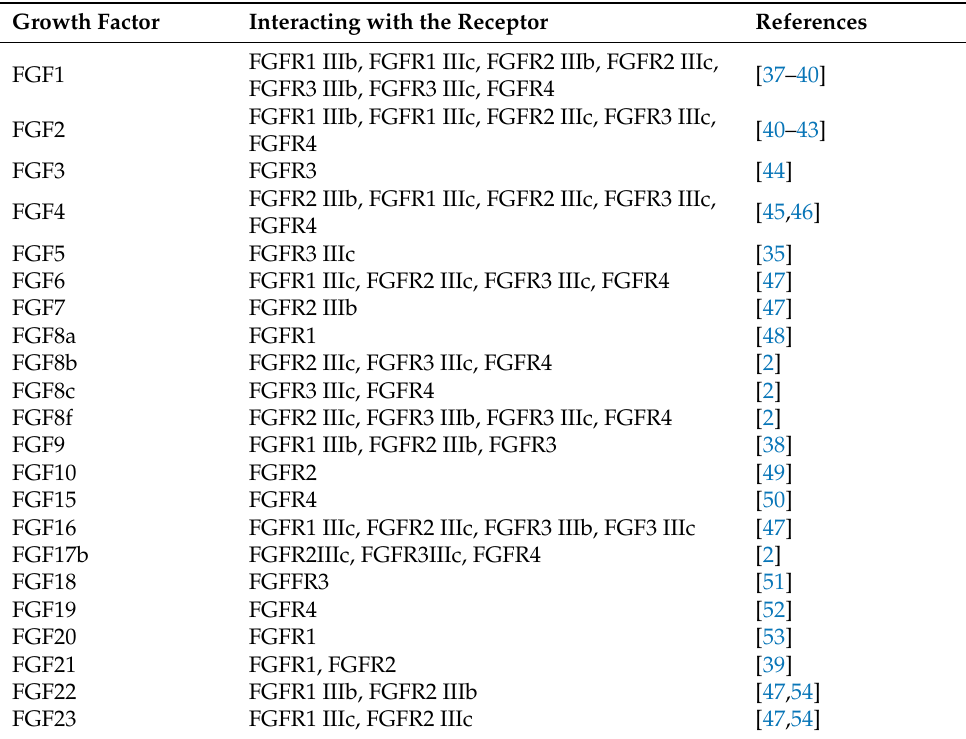
Table 2. Interaction of FGF with their